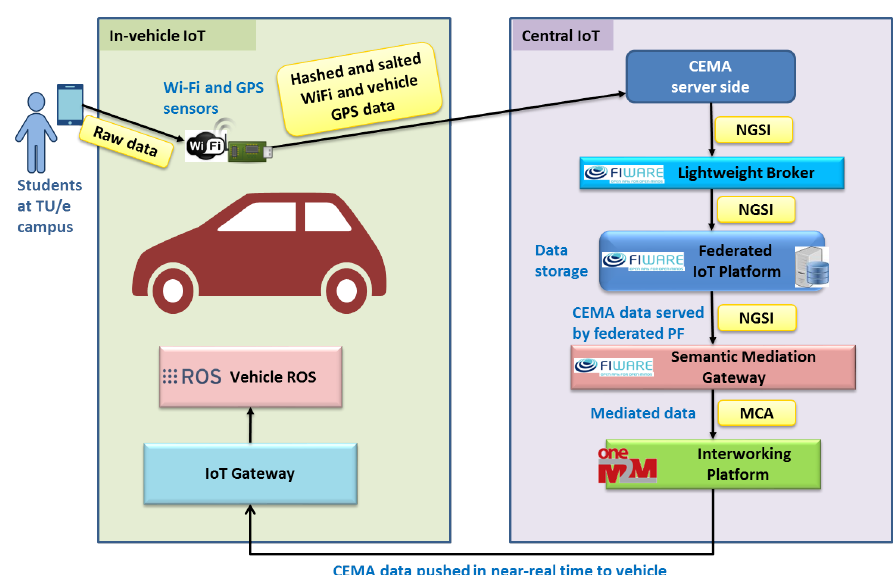
Figure 7. Integrated cloud and edge technologies: from vehicle to